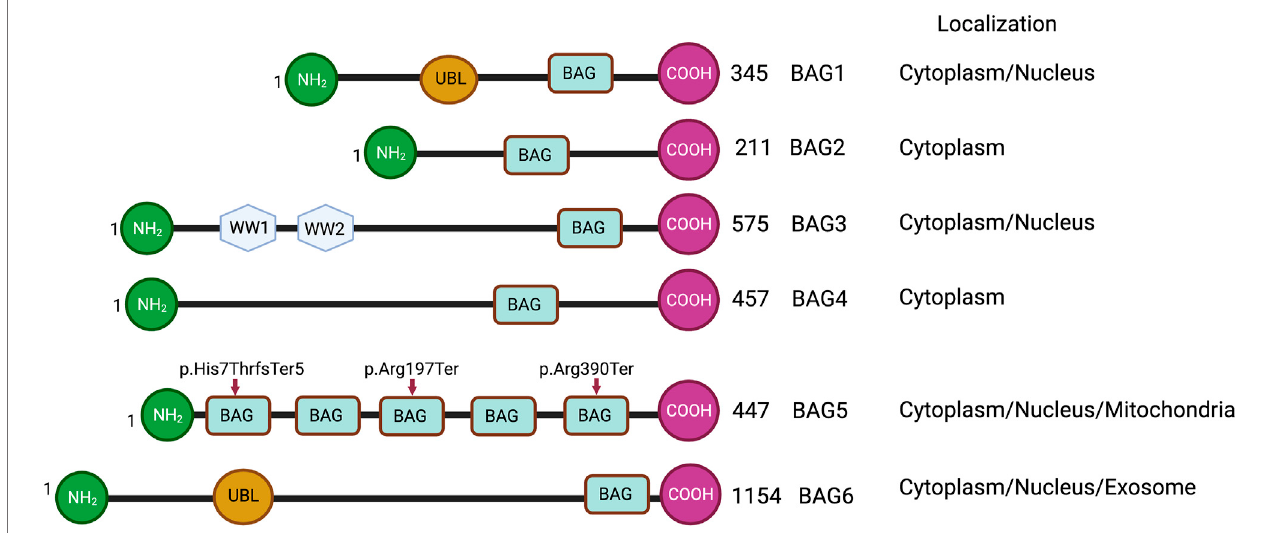
FIGURE 1 | Schematic representations of BAG family proteins, showing conserved domains and cellular localization. NH2 represents the N-terminal and COOH represents the C-terminal of protein. UBL represents a ubiquitin-like domain. BAG represents the BAG domain. WW represents WW domain. Arrowheads show the truncating variants of the BAG5